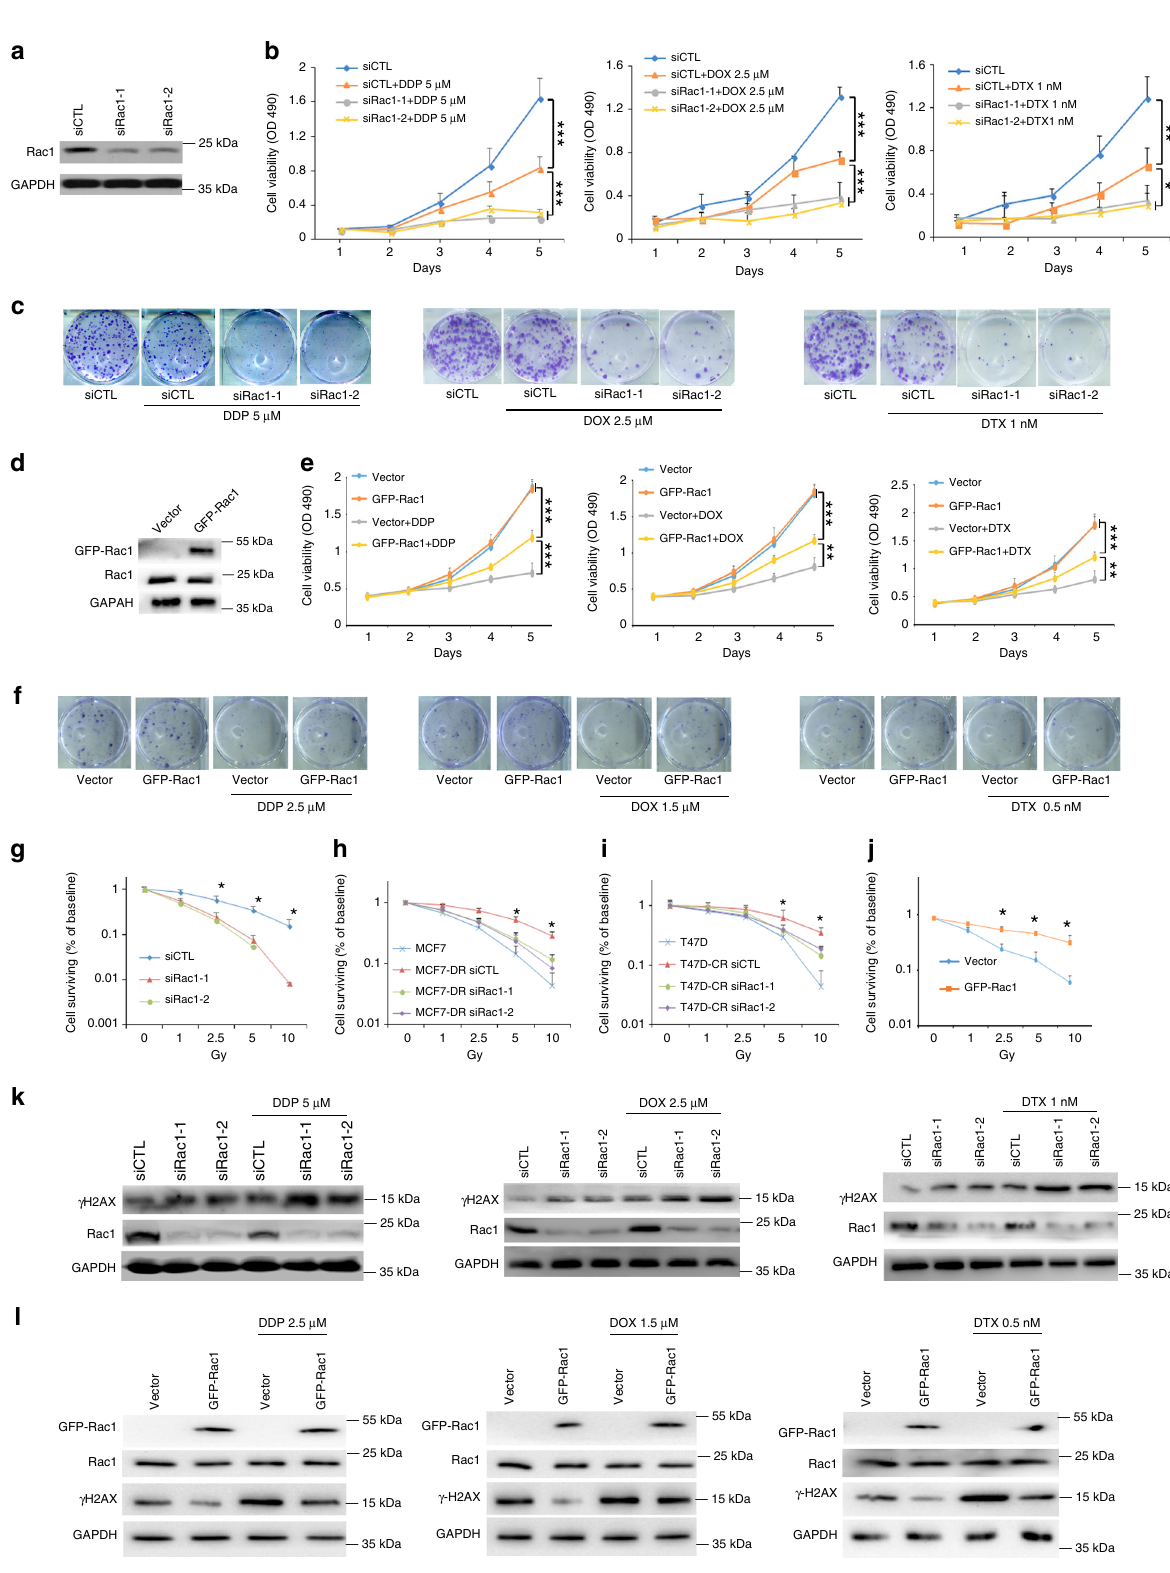
Manipulation of Rac1 level in MDA-MB-436, MDA-MB-231, and MCF-7DR cells revealed changes of p-ERK level along with Rac1 level (Fig. 3e, f and Supplementary Fig. 4B). Consistently, Rac1 inhibition with NSC23766 decreased p-ERK level in MDA-MB- 231 cells (Supplementary Fig. 4C). To explore whether Rac1 regulated aldolase activity via ERK signaling, we treated